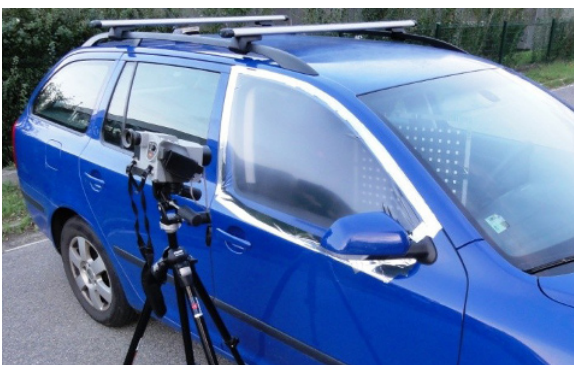
Fig. 10. The placement of measuring net between the front passenger area and the driver area